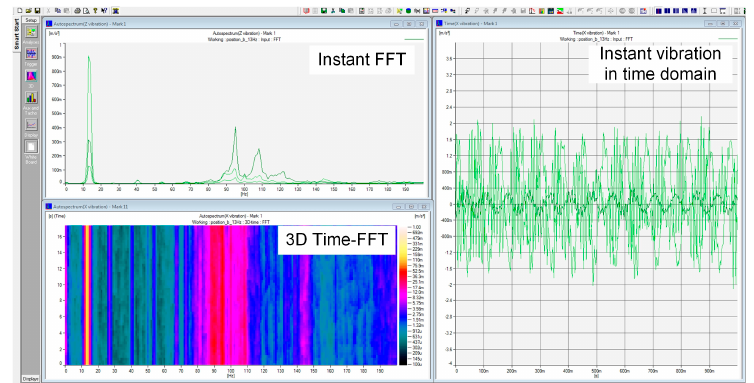
Figure 4. Interface of PULSE software in the vibration measurement.